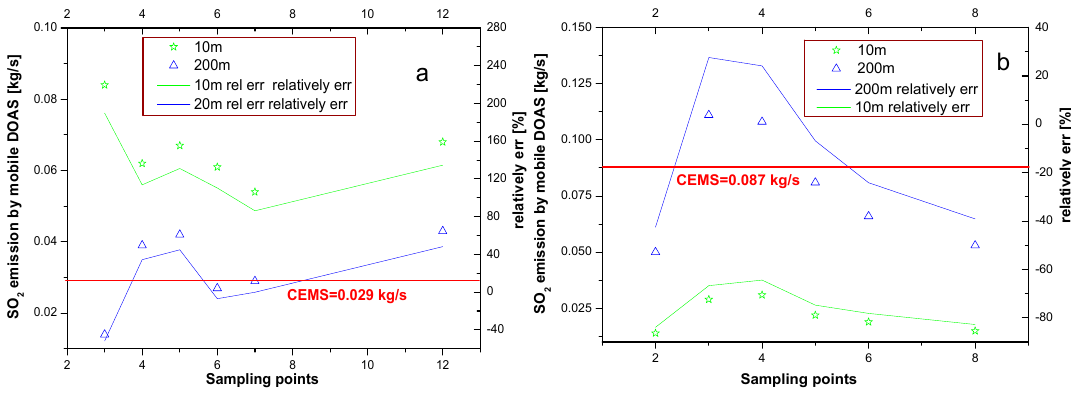
Figure 6. SO 2 emission and relative deviation. ( a ) SO 2 emission results on 26 October; ( b ) SO 2 emission results on 10 November. The dots and lines indicate SO 2 emission and relative deviation, respectively. The negative relative deviation indicates that the mobile DOAS result is lower than that of CEMS.